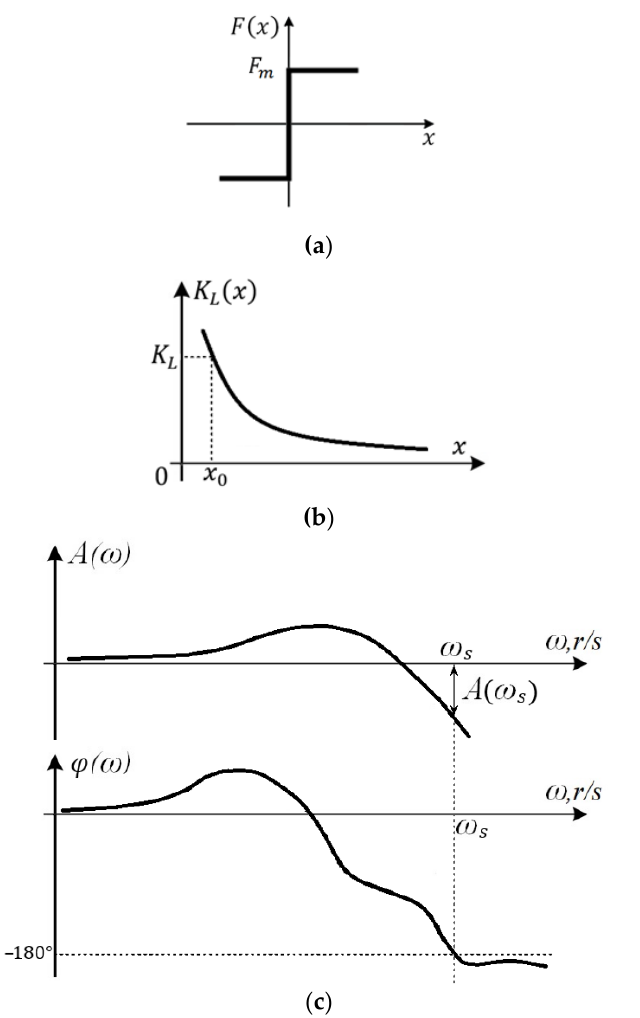
Figure 13. Nonlinear element function ( a ) and linearization coefficient function ( b ), nonlinear system frequency characteristics ( c ).